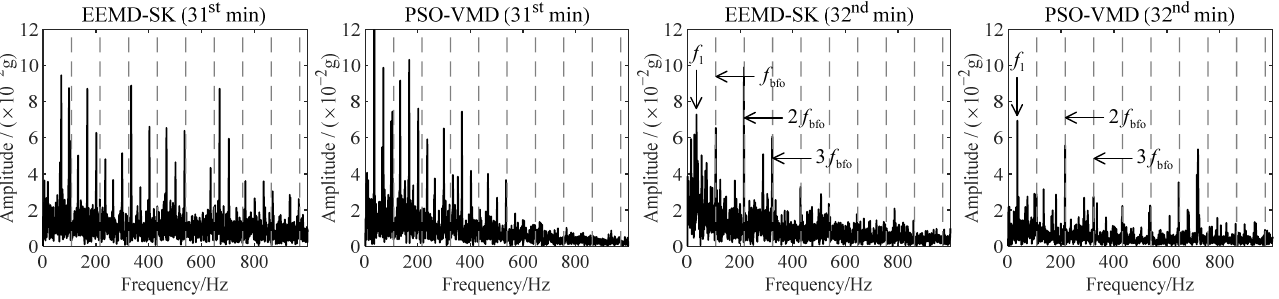
Figure A3. The spectrum obtained by EEMD-SK and PSO-VMD for the signals sampled at 31st and 32nd min.